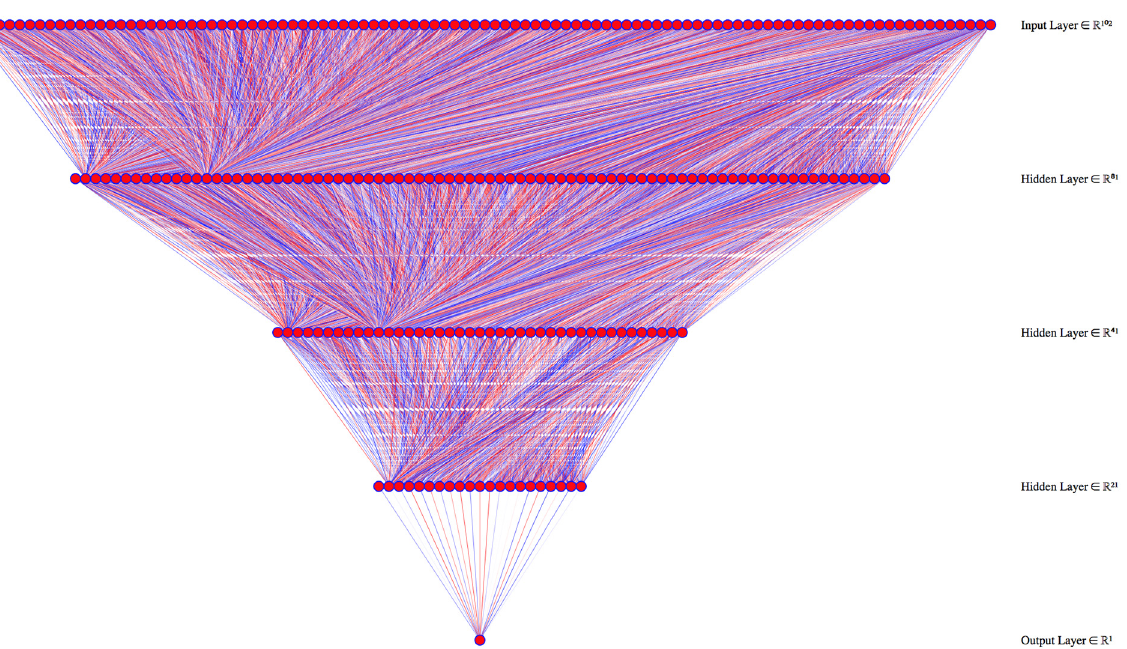
Figure 10. Deep learning model architecture for waste collection and disposal costs. We used 200 learning epochs to train the